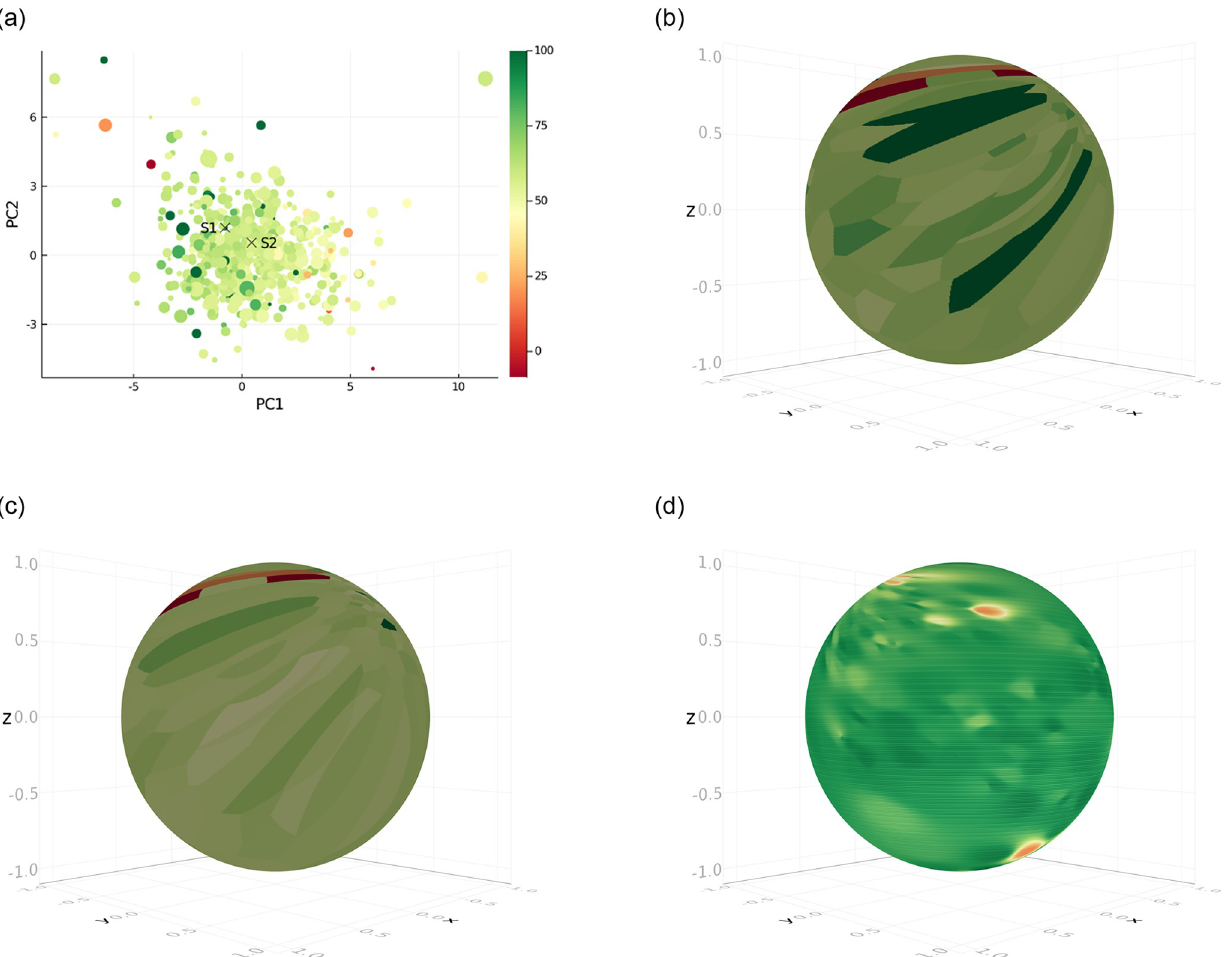
Fig 6. Stereographic representation of the data produced by the model. (a) Two-dimensional representation of the computed state values for the clinicians’ policy using PCA. Each dot is a state obtained through the method described in Section 2.3 with the size matching the number of corresponding observations in the dataset. The coloring corresponds to the computed state value. S 1 and S 2 are specific states from which stereographic representation is produced. (b) (Inverse) stereographic projection from the PCA plane to a sphere with center S 1 and radius 1. The coloring corresponds to the state values. (c) The coloring is changed to fit the computed state-action values for some specified action. (d) The sphere is now centered at S 2 and the coloring corresponds to a different action. The state-action values were smoothed using inverse distance weighing [33] instead using of piece-wise constant